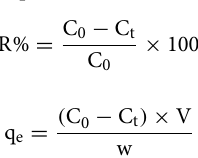
Characterization. MIL-125(Ti)/MIL-53(Fe)/CNT@Alg composite microbeads were thoroughly character- ized by; Fourier Transform Infrared spectra (FTIR- Tensor II, Bruker) to investigate the chemical composition of the synthesized microbeads. Furthermore, X-ray diffractometer (XRD- MAC Science M03XHF) was used to distinguish the crystal phase. The surface morphology was identified by a Scanning Electron Microscope (SEM- Hitachi-S4800). Besides, X-ray photoelectron spectroscopy (XPS- Thermo scientific-ESCALAB-250Xi VG) was employed to clarify the elemental compositions of the adsorbent. The specific surface area of composite micro- beads was measured by Bruner-Emmett-Teller method (BET- Beckman coulter SA3100), while their surface charges were determined by Zeta potential (ZP- Malvern-UK). Batch experiment.